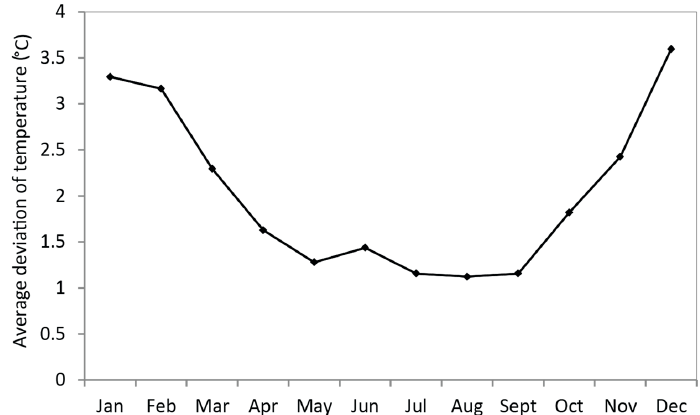
Figure 3. Monthly variability of temperature anomalies for the period 1960–2011 (combination of the three weather stations).